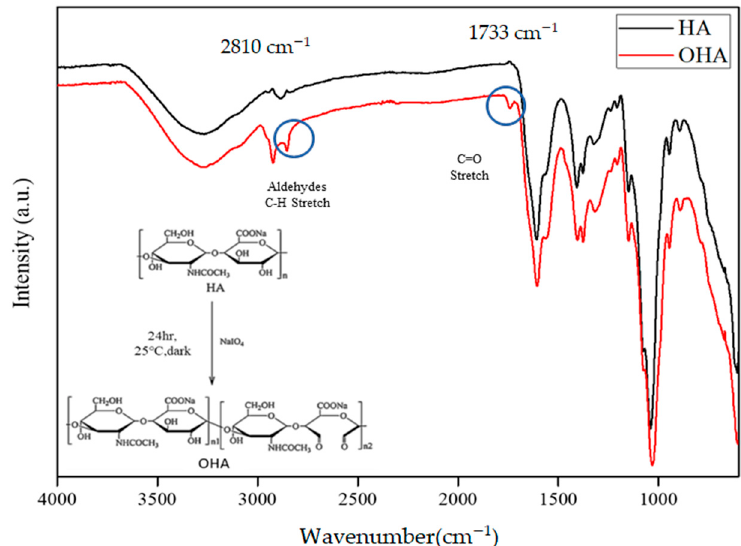
Figure 1. FTIR spectra of pure hyaluronic acid and oxidized hyaluronic acid (OHA).